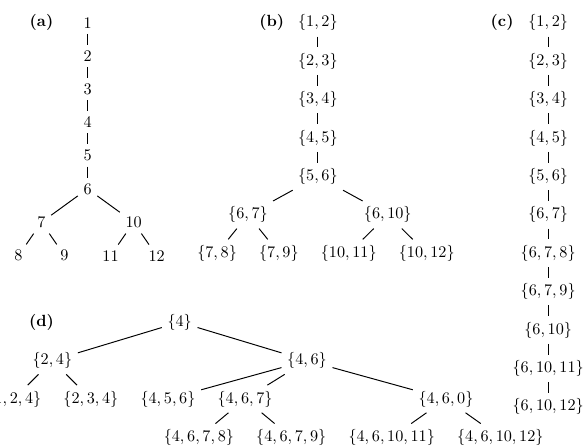
Figure 1. Various tree decompositions of an undirected graph G = ( V , E ) shown at ( a ). The de- compositions justify ( b ) tw ( G ) treewidth, the decompositions also justify ( b ) tw 2 ( G )